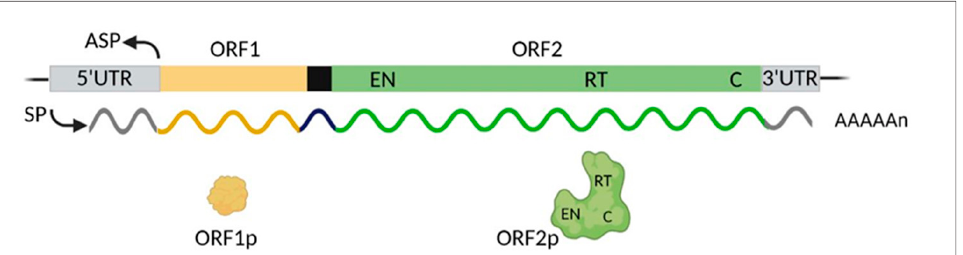
Figure 1. Schematic map of the human LINE-1 full-length retroelement and encoded products. The main genetic regions include: SP , sense promoter; ASP , anti-sense promoter; 5 ′ -UTR and 3 ′ -UTR , untranslated regions; ORF1 and ORF2 , open reading frames 1 and 2. The black box represents the intergenic spacer between the two ORF s. The polycistronic primary transcript, and the encoded protein products, are represented in the same color code. The ORF2 product encompasses regions encoding endonuclease (EN), reverse transcriptase (RT), and cysteine-rich (C) domains. The image was created using BioRender (biorender.com) .